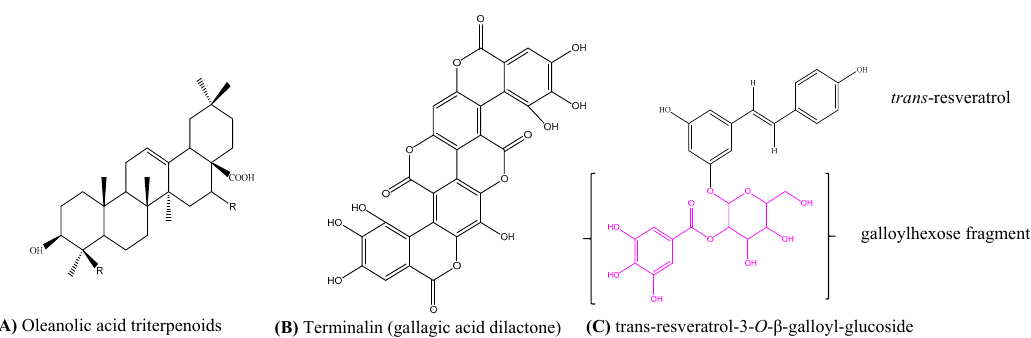
(A) Oleanolic acid triterpenoids (B) Terminalin (gallagic acid dilactone) (C) trans-resveratrol-3- O - β -galloyl-glucoside Figure 4. Chemical structures of some of the characterized compounds in the stem wood and stem bark of T. brownii . ( A ) oleanane type triterpenoids (compounds 1 and 2 ); ( B ) Terminalin (compound 6 ) and ( C ) trans -resveratrol-3- O - β -galloyl-glucoside (compound 4 ).